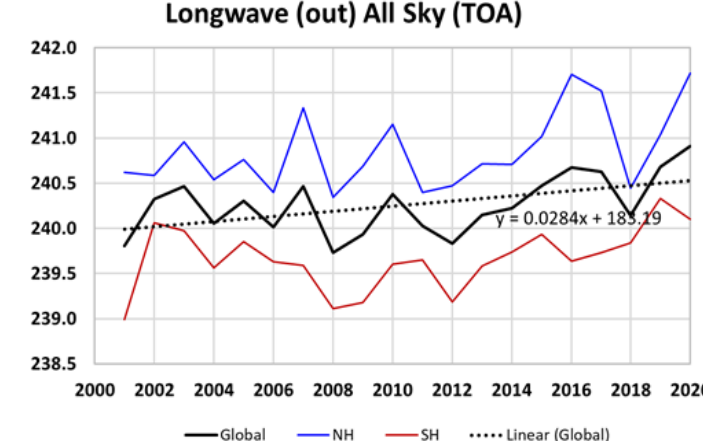
Figure 2. The increasing trend of the LW flux. The average effect is +0.6 ± 0.2 W/m 2 for two decades. The Northern hemisphere is warmer than the South and therefore shows a higher LW (out) value.